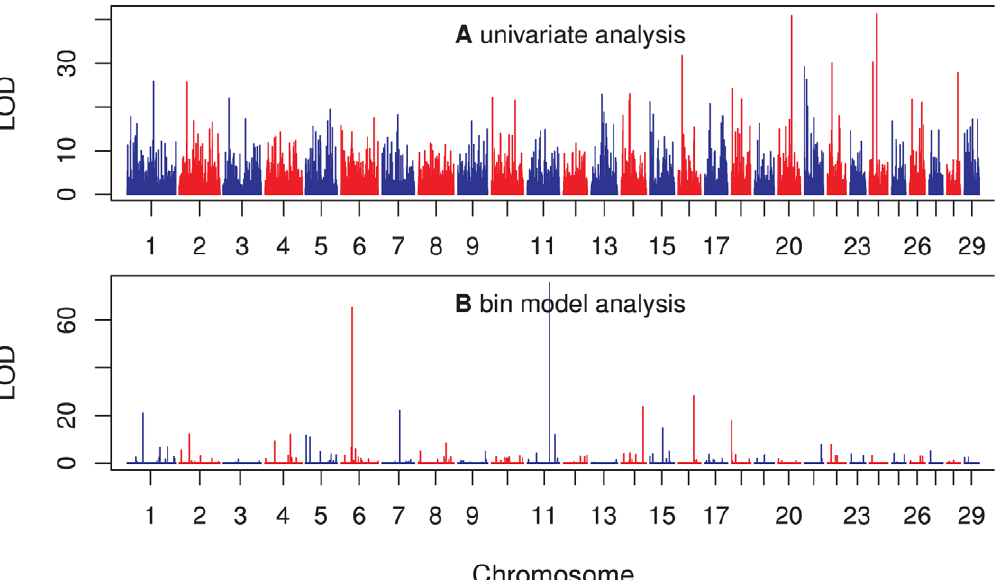
Figure 7. LOD scores of individual markers and bins of the carcass trait of beef cattle. (a) The top panel shows the LOD scores of individual marker analysis (simple regression analysis for each marker). (b) The panel at the bottom shows the LOD scores of the bins obtained from the adaptive infinitesimal model analysis with a bin size of 5.9 log 10 bp (the optimal bin size). The number of bins under this optimal size was 3186.